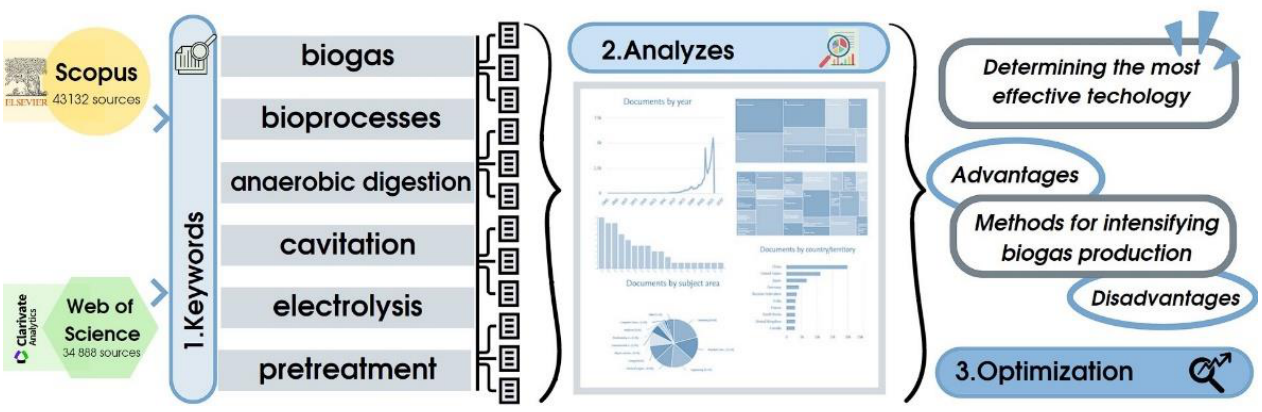
Figure 1. Methodological approach for the analytical review from Scopus and Web of Science databases.